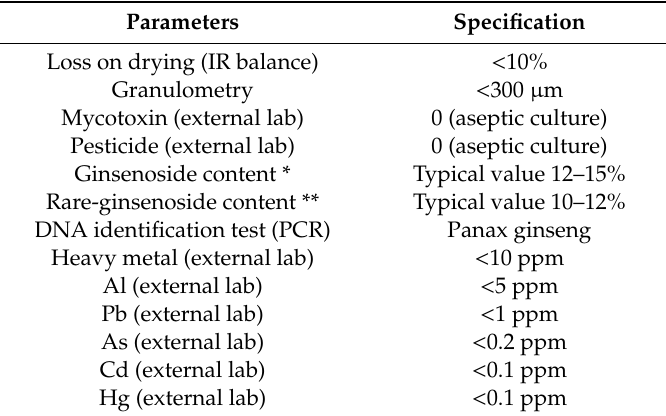
Table A1. Specification of red ginseng, HRG80